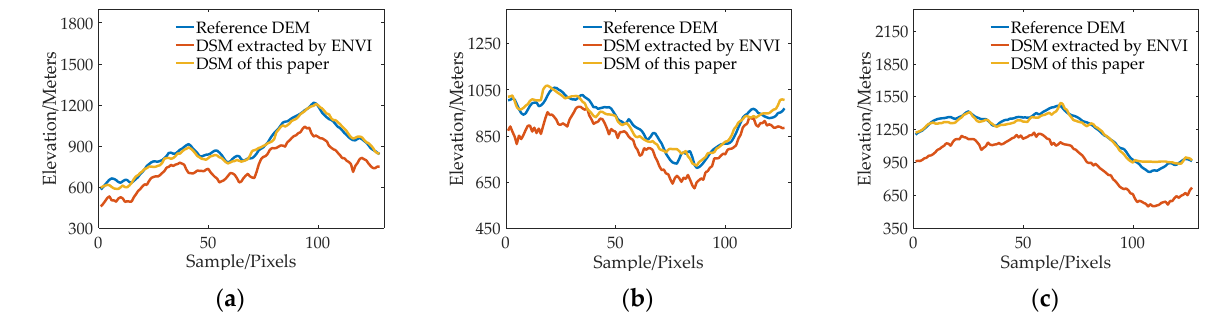
Figure 13. The elevation profiles comparison of three mountain peak regions: ( a ) Region 1; ( b ) Region 2; ( c ) and Region 3.